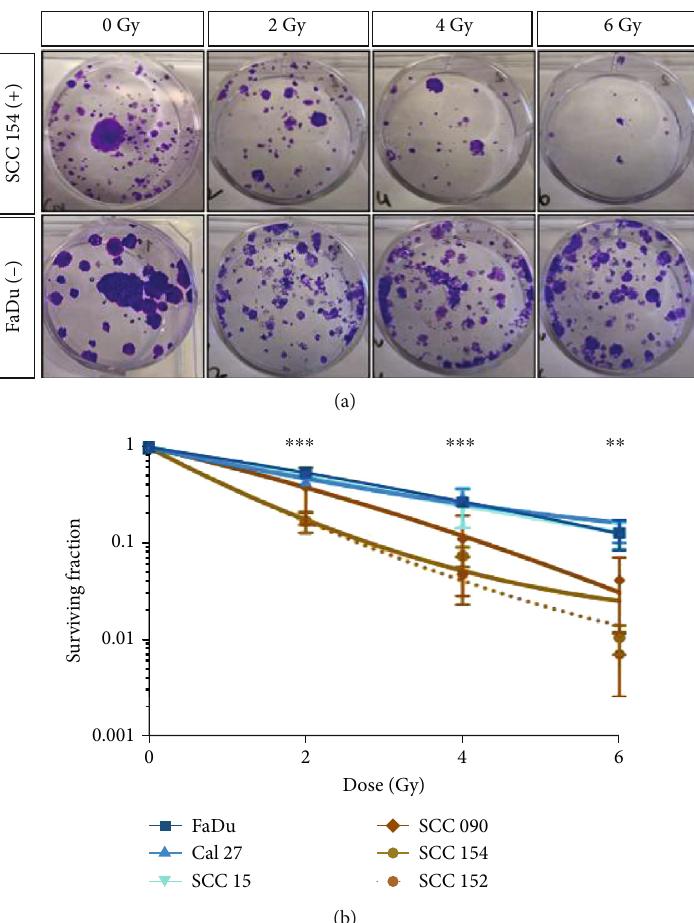
Figure 3: E ff ect of radiation on HPV-negative and HPV-positive cell survivability. (a) Examples of clonogenic growth observed in HPV- negative, FaDu, and HPV-positive SCC 154 cell lines at 0, 2, 4, and 6Gy external beam irradiation. (b) Surviving fraction curve of three HPV-negative and three HPV-positive cell lines after 0, 2, 4, and 6 Gy irradiation. Means ± SD of three independent experiments with three replicates each. Statistical signi fi cance is shown between FaDu and SCC 154. ∗∗ P < 0 : 01 and ∗∗∗ P < 0 : 001 . Quanti fi cation for all cell lines is shown in Supplementary Fig.